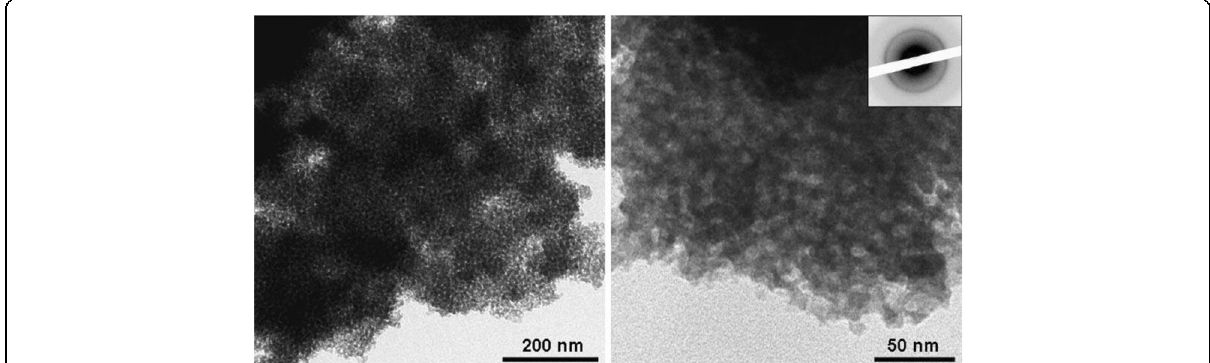
Fig. 8 TEM images and an electron diffraction pattern of mp-C3N4 after removal of the silica nanoparticles. Reproduced with permission [123]. Copyright John Wiley & Sons Inc.,